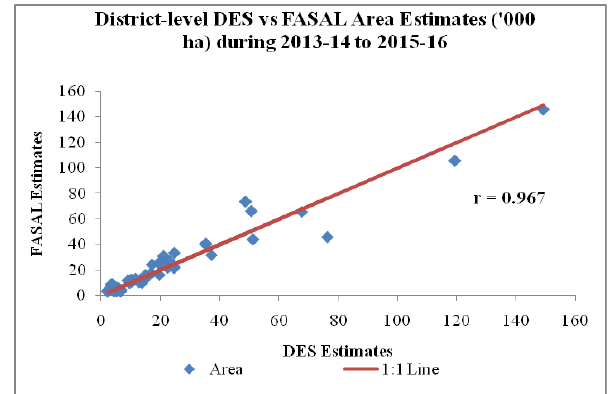
Figure 16. District-wise Area ('000 ha) Comparison of Jute DES and FASAL Estimates (Pooled 3 years, 2013-2015)